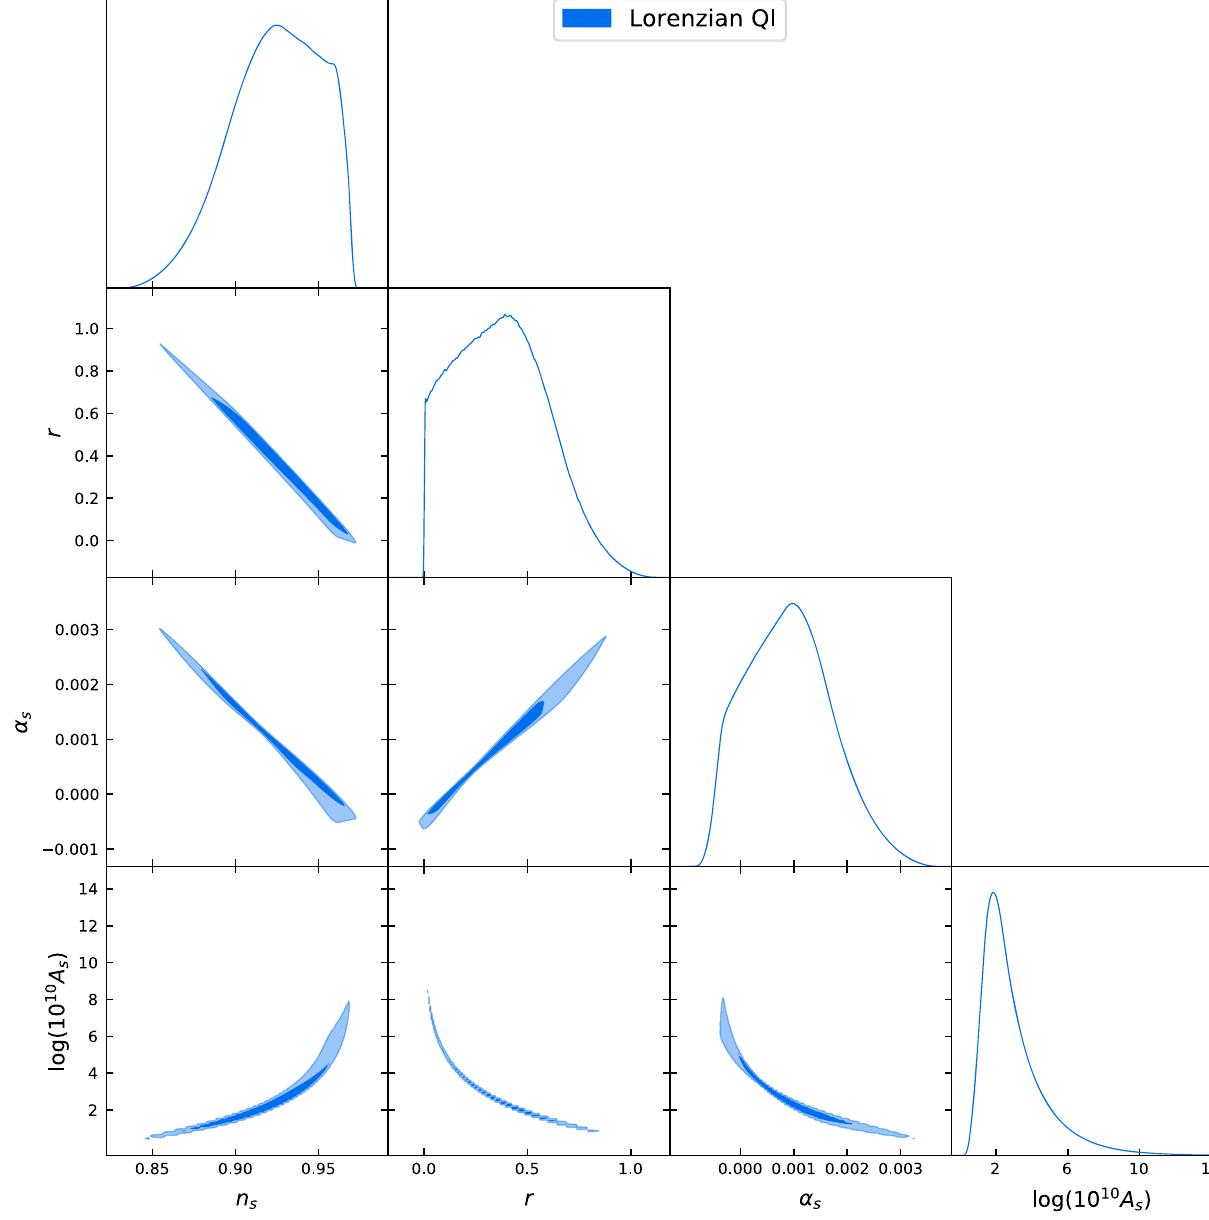
Fig. 2 The predicted scalar to tensor ratio r and the running α s vs. the primordial tilt n s of the model. The observations are well within the Planck 2018